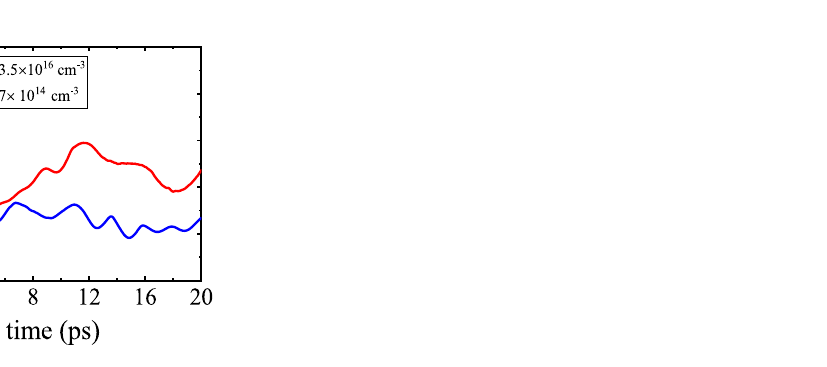
Figure 12. Variation of the bunch emittance ǫ N,x as a function of the propagation time for two beam densities, n 16 cm 3 and n 14 cm 3 − − b0 = 3.5 × 10 b0 = 7 × 10